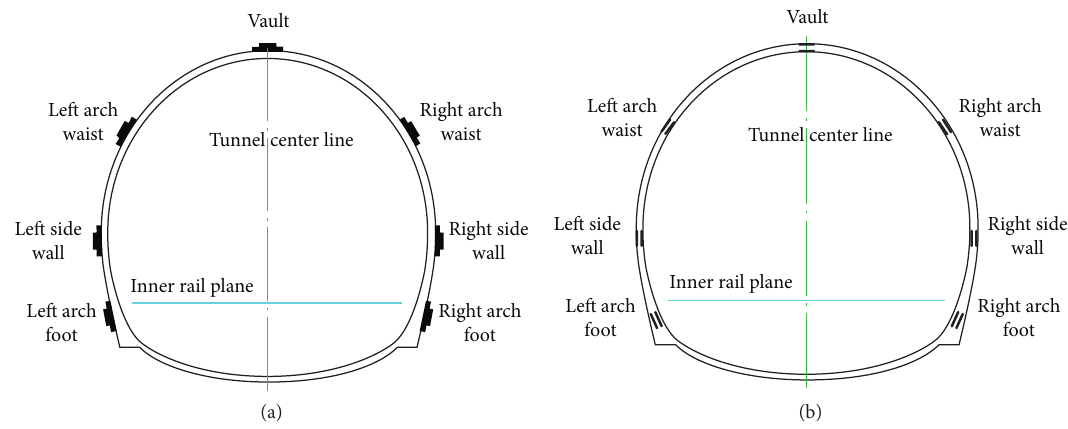
Figure 12: Layout of the monitoring points for internal force. (a) Surrounding rock pressure. (b) Internal stress of